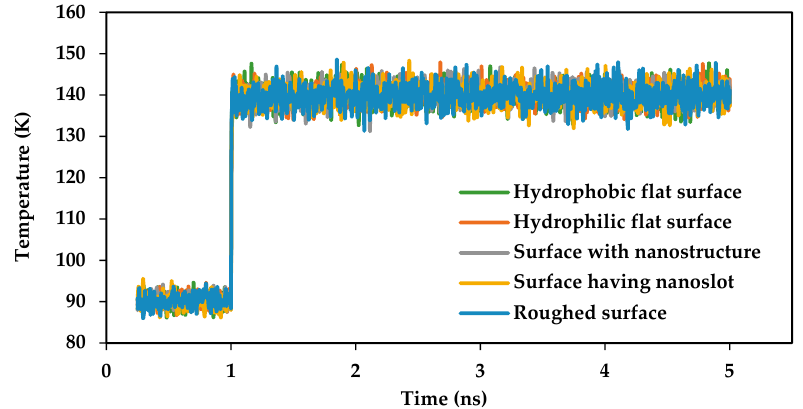
Figure 5. Temperature of solid wall for different surface textures .